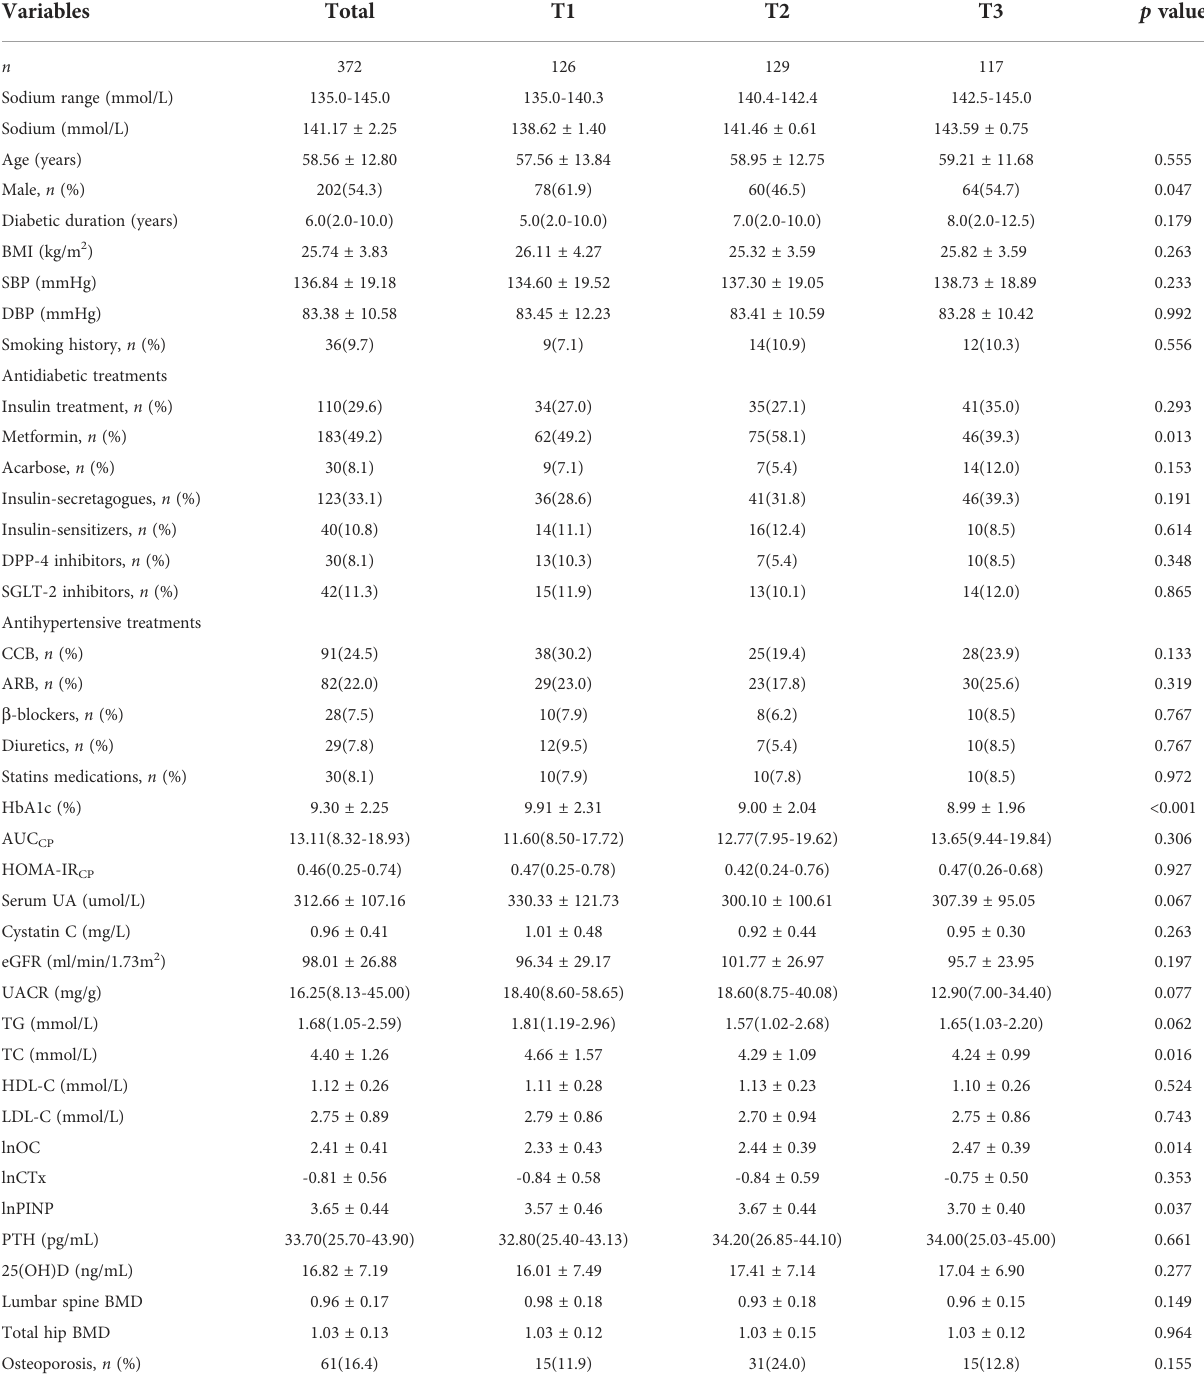
TABLE 1 Patient